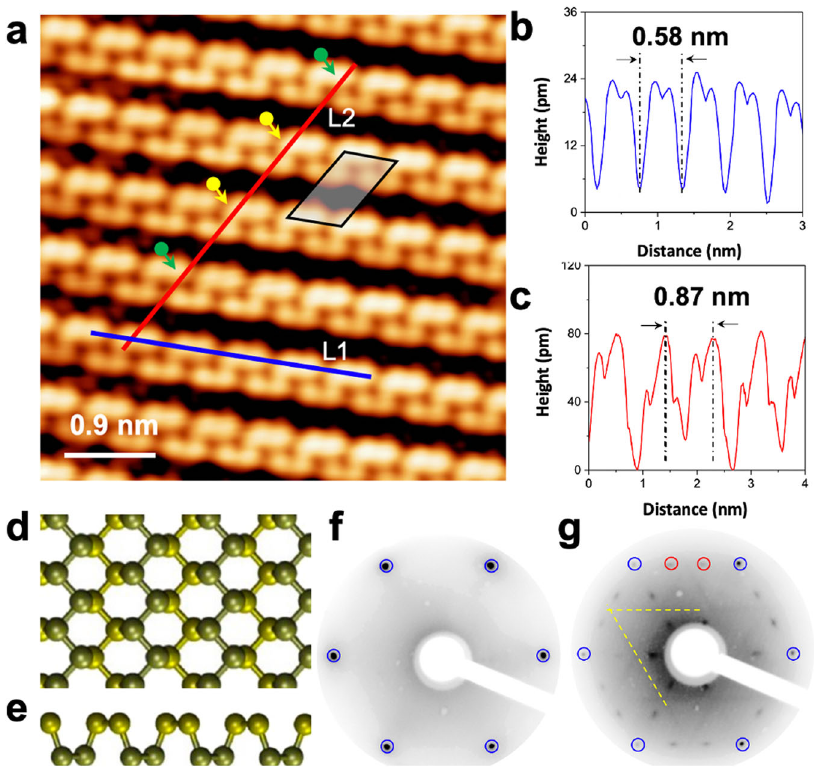
Fig. 2 Atomic structures of P chains on Ag(111). a Atomically resolved STM image, showing parallel P chains (5 × 5 nm 2 , U = − 0.1 V, I = 1.00 nA). The unit cell of P chain structure is indicated by the black rhombus. b Line scan measured along the line L1 in a . The periodicity of the brightest protrusions is around 0.58 ± 0.01 nm, corresponding to twice the lattice constant of the Ag(111) surface (2 × 0.289 nm = 0.578 nm). c Line scan measured along the line L2 in b . The line pro fi le L2 measures the corrugation across the P chains along the other main direction of Ag(111) in a and shows a periodicity of 0.87 ± 0.01 nm, which is equal to three times the lattice constant of Ag(111) surface (3 × 0.289nm = 0.867 nm). d , e Structural model of black phosphorene layer viewed from the top and side, respectively. f , g Low energy electron diffraction patterns recorded at 56 eV corresponding to the bare Ag(111) and after deposition of ~0.8 ML of P on Ag(111), respectively. The (1 × 1) spots of Ag substrate are highlighted by blue circles, the ×3 are highlighted by red circles, and the ×2 are highlighted by dashed yellow